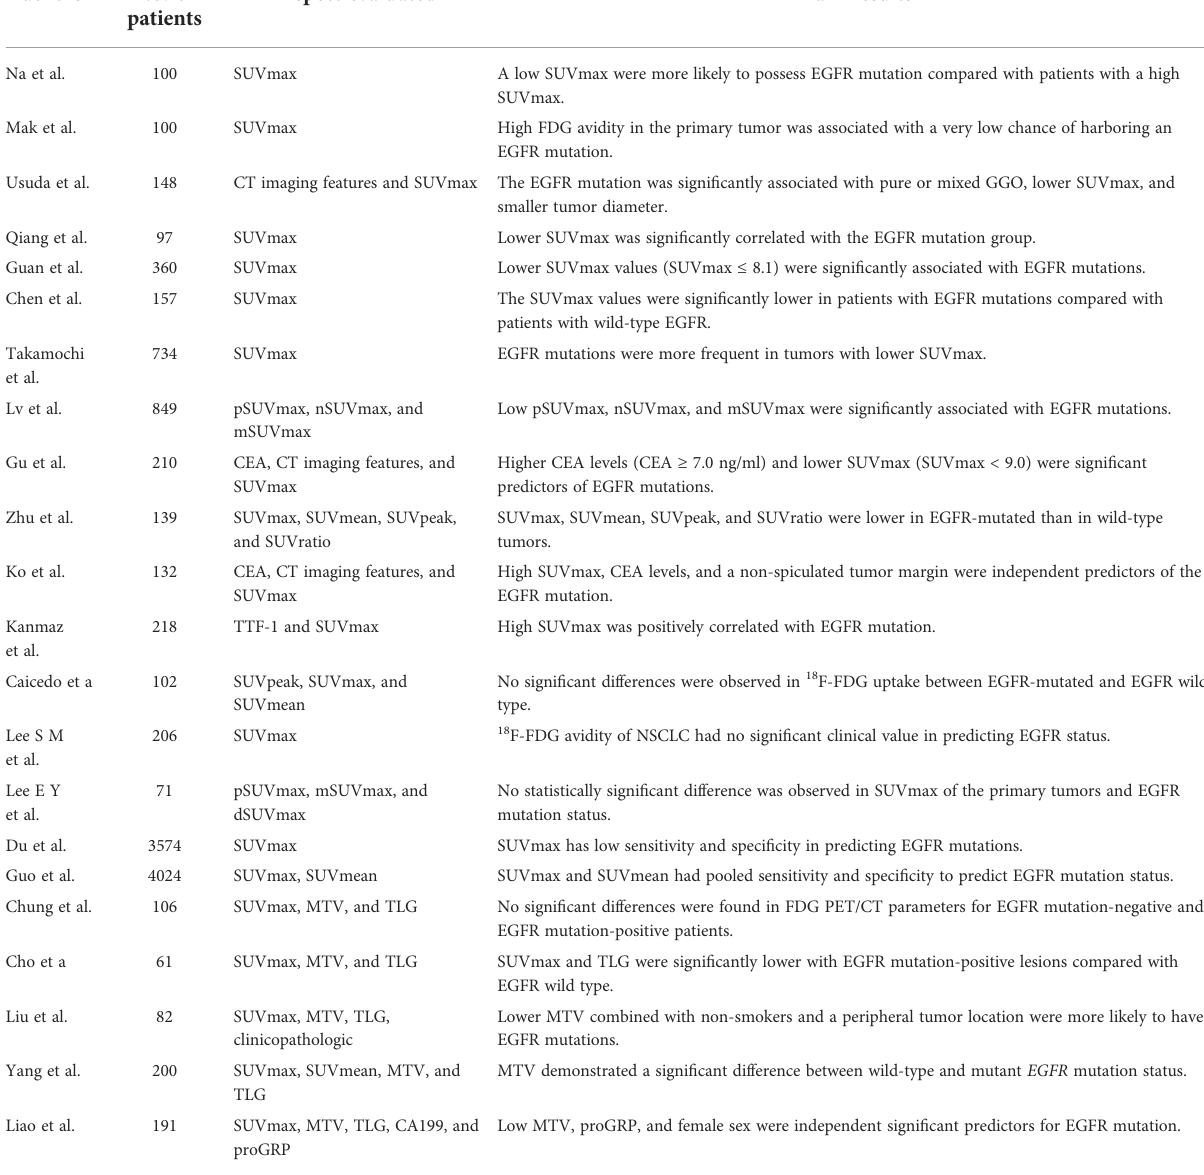
TABLE 1 Recent publications about the association of 18 F-FDG metabolic parameters of PET/CT with epidermal growth factor receptor mutation status in non-small cell lung cancer. Authors No.